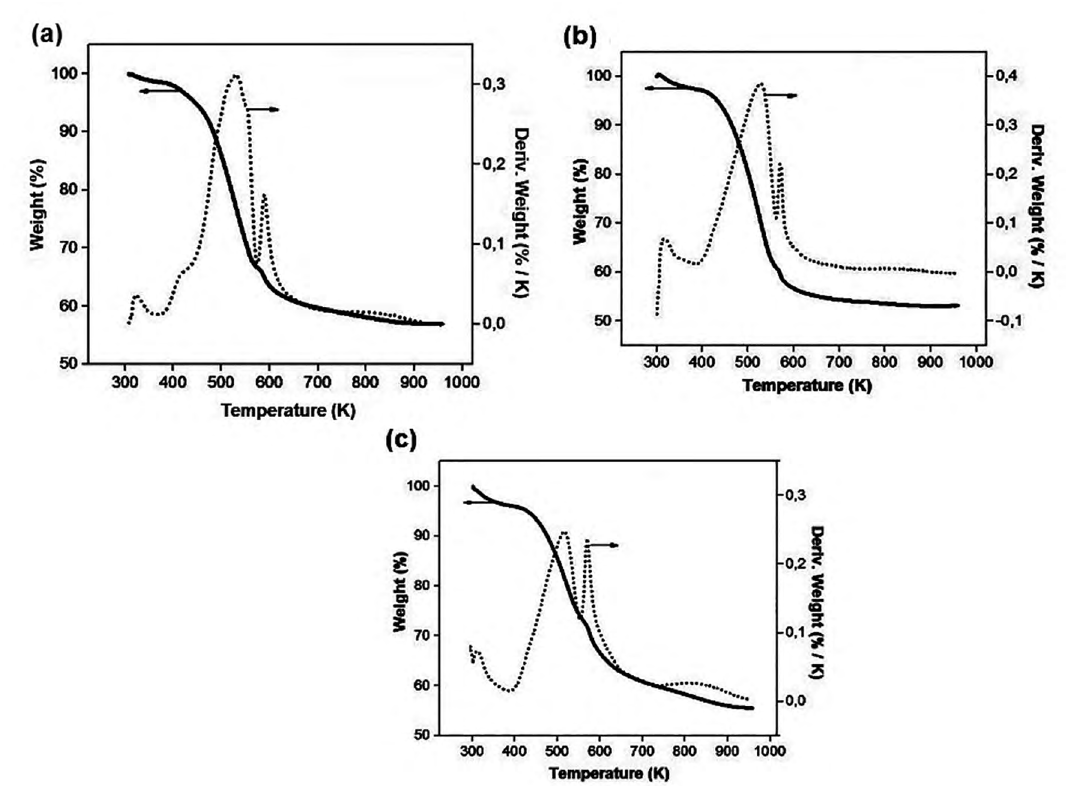
Figure 6. TGA and DTG profiles as-synthesized of (a) MCM-41, (b) Al-MCM-41(50), (c)